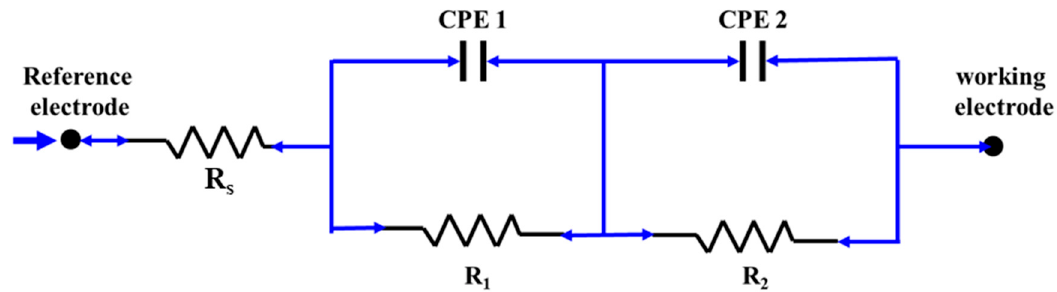
Figure 9. Electrochemical Equivalent Circuit (EEC) model circuit for IN718 alloy obtained out of EIS data.